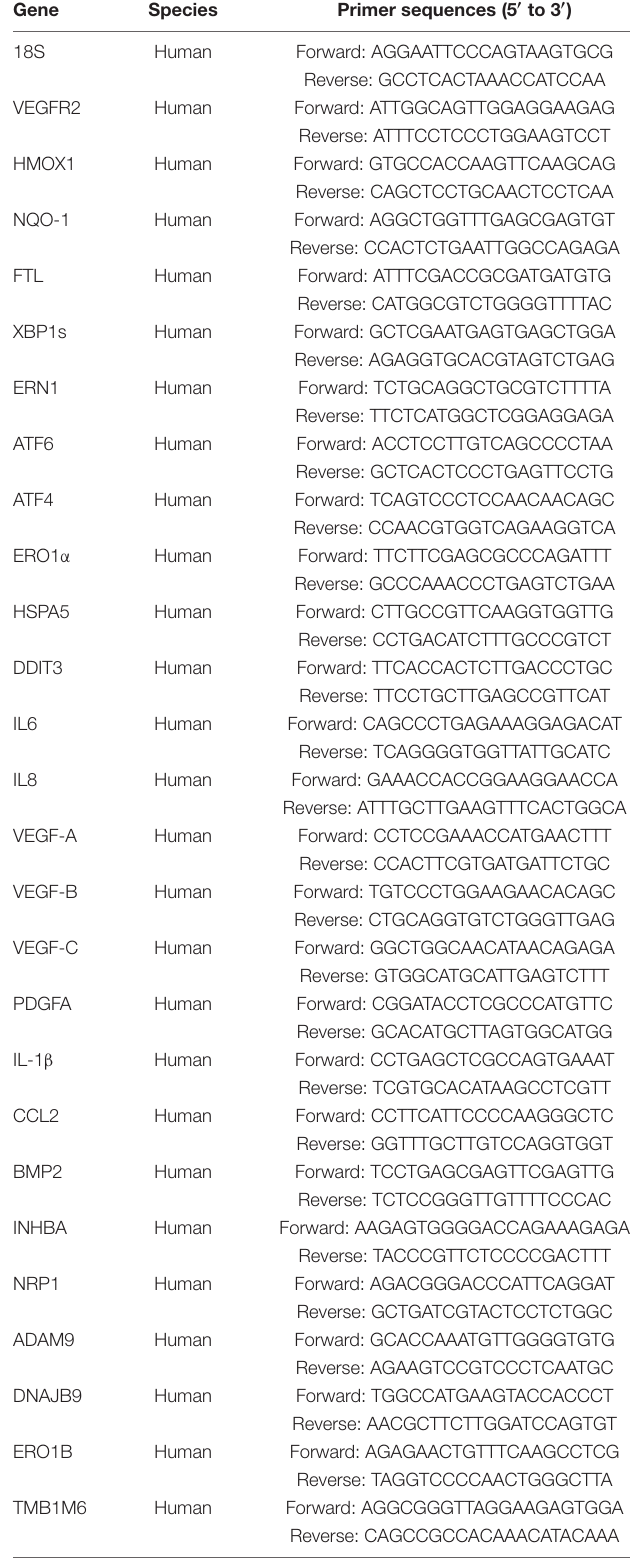
TABLE 1 | List of primer sequences used for